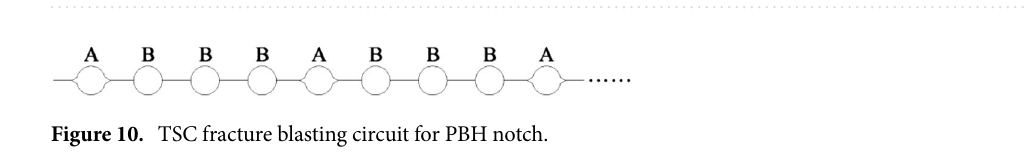
Figure 9. Crack propagation of blasting excavation of rock mass model within 5 ms (positive values represent tensile stresses and negative values represent compressive stresses).